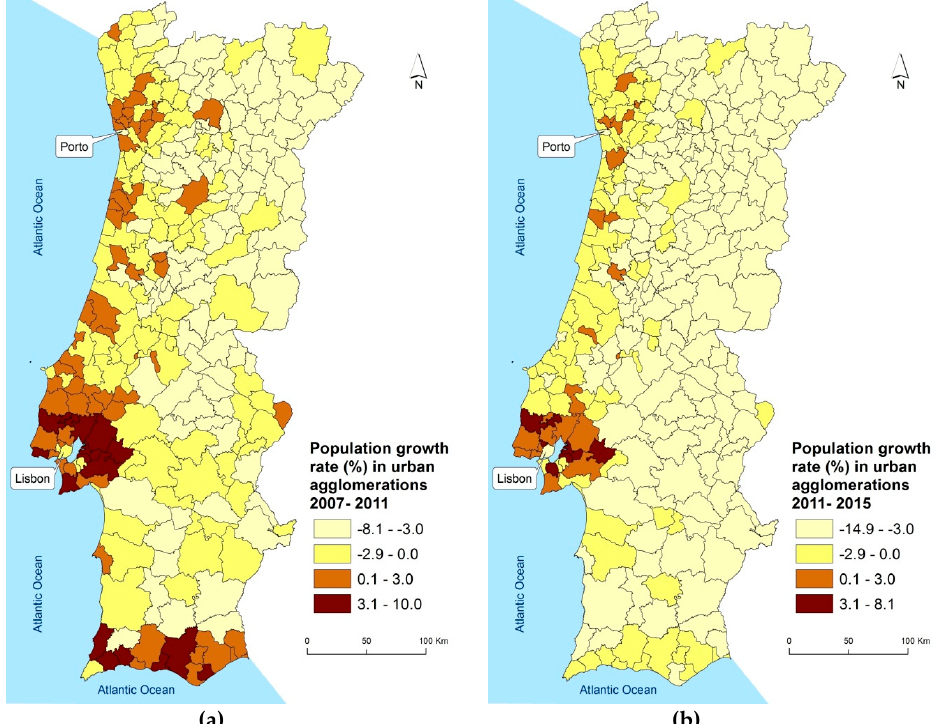
Figure 3. Population growth rate in urban agglomerations per municipality (%) for 2007-2011 (a) and 2011–2015